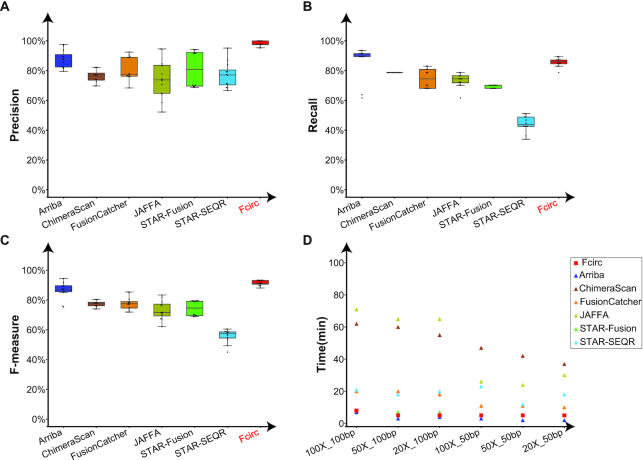
Performance comparison of different gene fusion detection tools in simulated RNA-Seq data. Comparison of precision (A), recall (B), F-measure (C), and computing time (D) across 7 fusion detection tools, including Arriba, ChimeraScan, FusionCatcher, JAFFA, STAR-Fusion, STAR-SEQR, and Fcirc. In Fig. 4A-C, the black lines in the box (from top to bottom) represent upper quartile, median and lower quartile, respectively; the top and bottom black line represent upper extreme and lower extreme, respectively; the black dots represent data points.